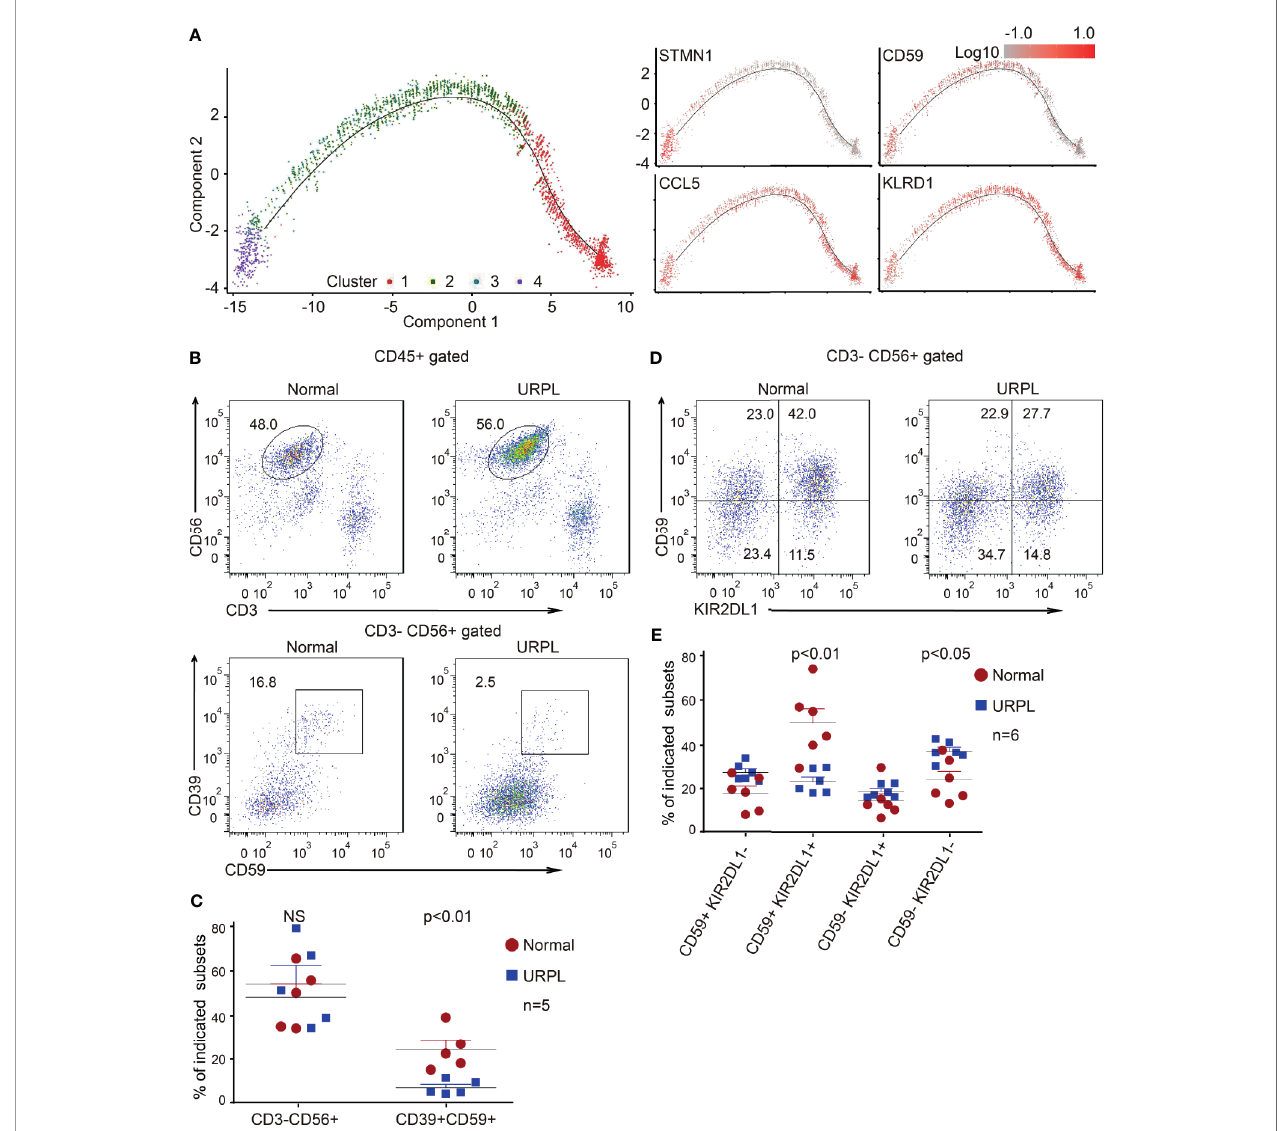
FIGURE 3 | Developmental trajectory and alterations of dNK subsets in URPL deciduas. (A) Developmental trajectories of dNK subsets (left) with the expression on indicated feature genes (right). (B) Representative fl ow cytometry plots showing the proportion of CD39 + CD59 + dNK cells among gated dNK (CD3 − CD56 + ) cells from normal control (left) and URPL patient (right). (C) Quanti fi cation of CD3 − CD56 + total dNK (left panel) and CD3 − CD56 + CD39 + CD59 + (right panel) population in decidual tissues from normal (n=5) and URPL patients (n=5). (D) Representative fl ow cytometry plots showing the proportion of dNK subpopulations (CD59 + KIR2DL1 − , CD59 + KIR2DL1 + , CD59 − KIR2DL1 + , CD59 − KIR2DL1 − ). (E) Quanti fi cation of dNK subpopulations showing in (D) . Normal (n=6) and URPL patients (n=6). Signi fi cance was evaluated with Student ’ s t -test. All points were shown, and bars represent means with SEM. Statistical analysis of fl ow cytometry data was performed using GraphPad Prism 5.0